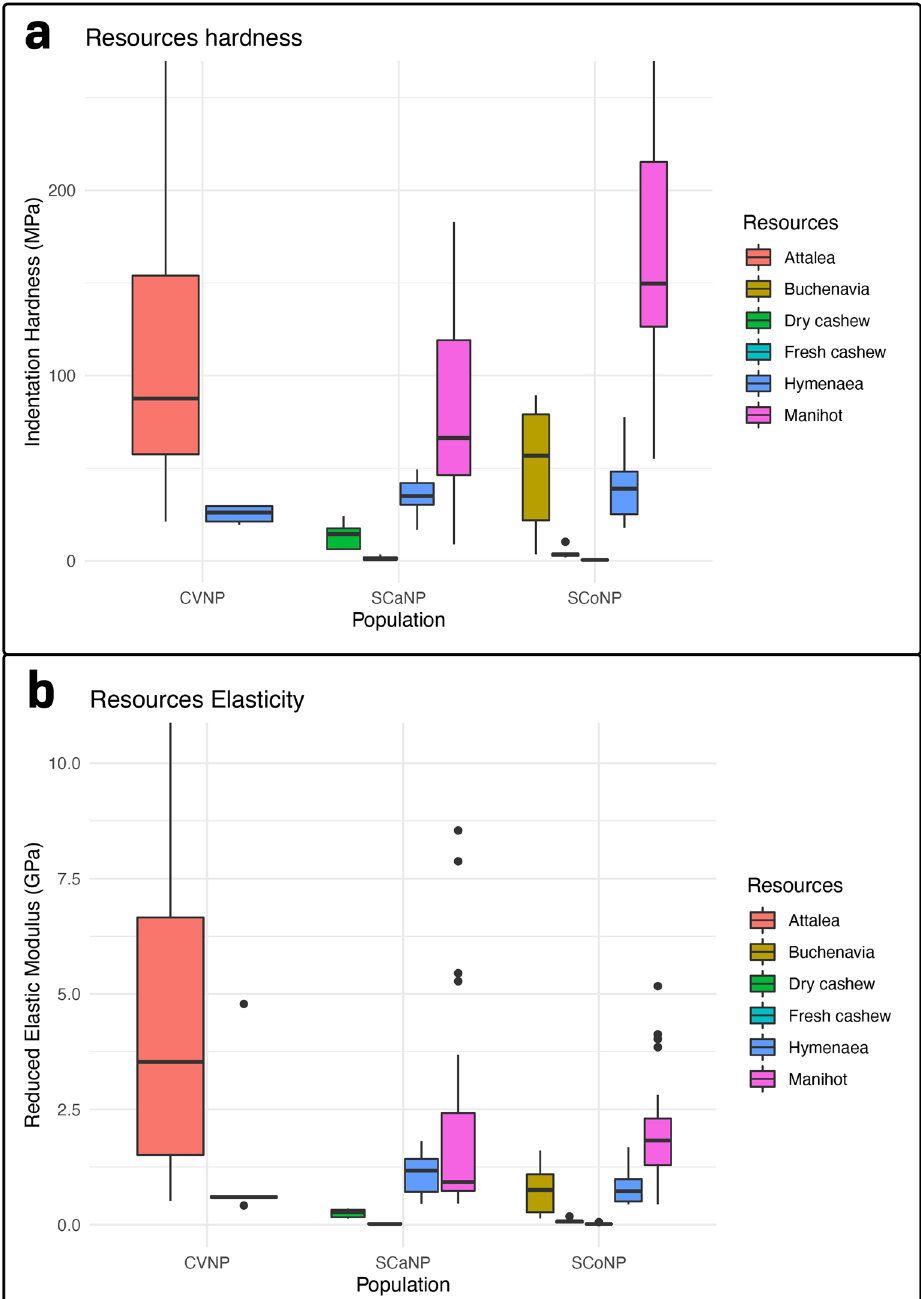
Figure 3. Physical properties of the food resources processed with stone tools in each study site. ( a ) Food resources hardness per study site. ( b ) Food resources elasticity per study